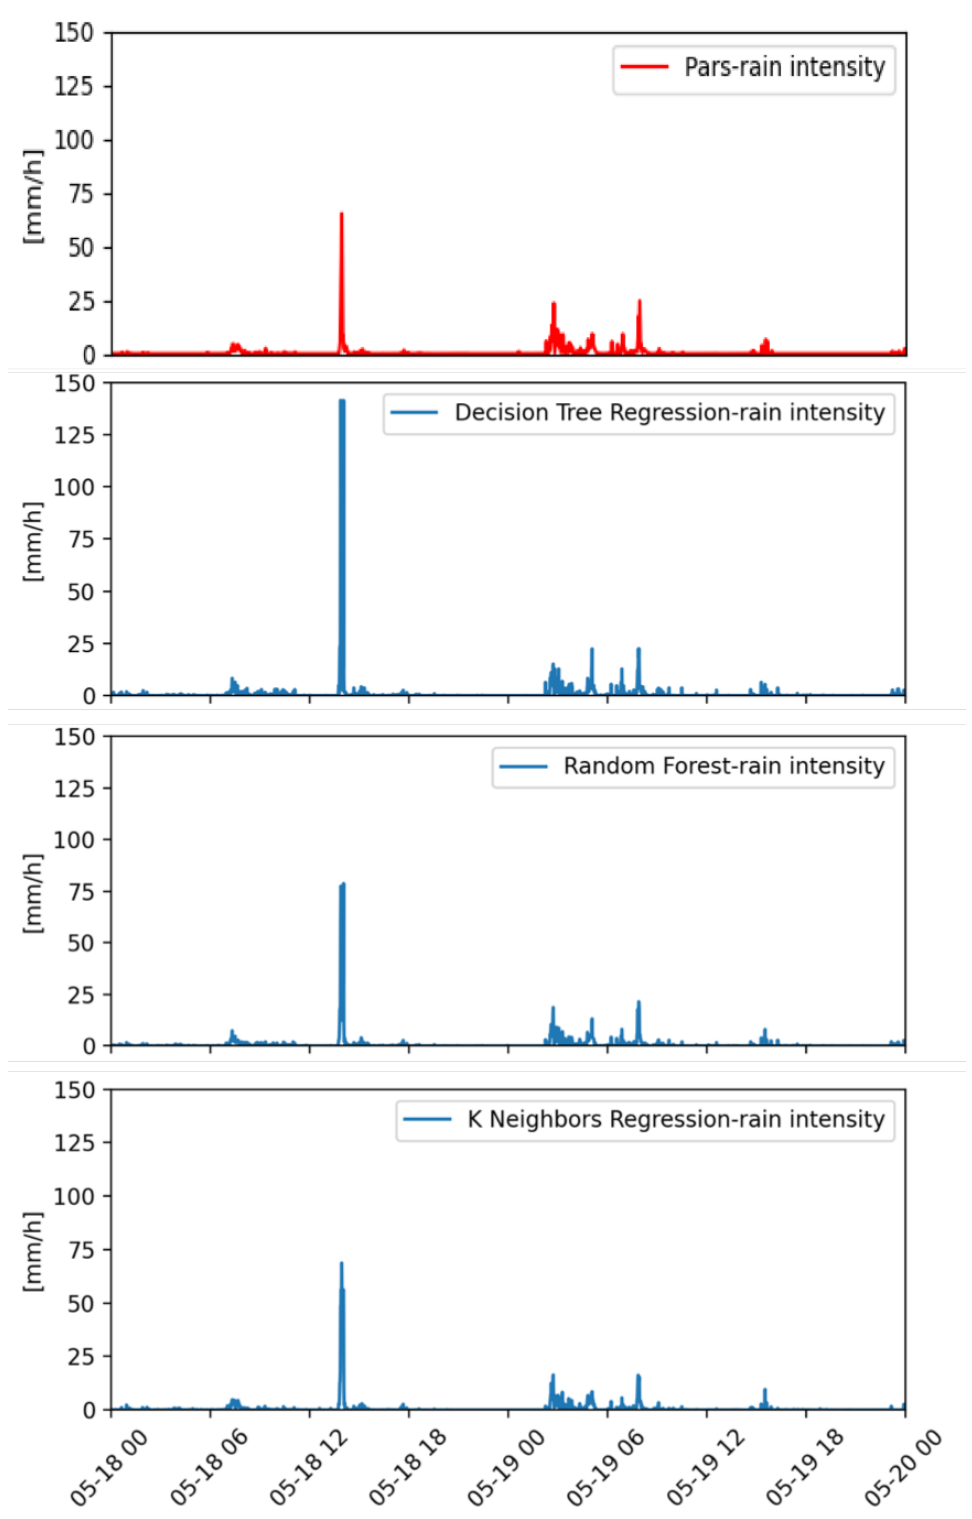
Figure 6. Instantaneous rainfall rate as measured by a co-located reference laser disdrometer (on top) and as estimated by the ML (DTR, RF, KNNR) approaches (from top to bottom, respectively). Data are relative to 18 and 19 May